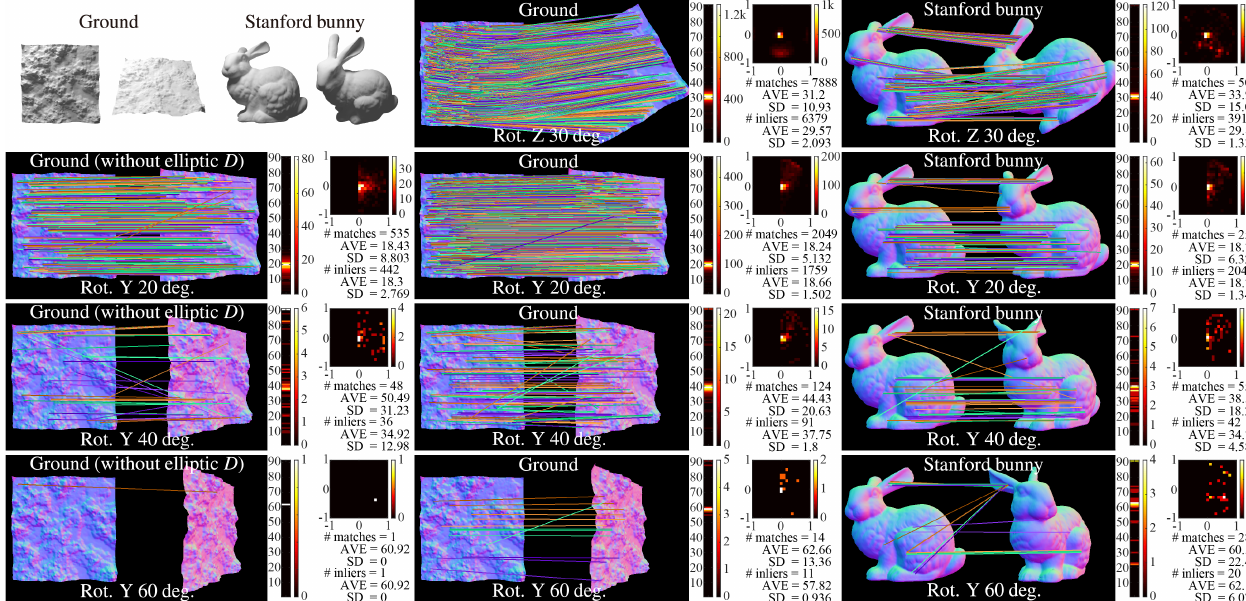
Figure 4. Estimated motion between images of a rigid body model, “Ground” or “Stanford bunny”, and the rotated one, using BIFNOM. For each case, a histogram and statistics for estimated rotation angles and a heat map for estimated rotation axes are described. In the heat map, XY components of a unit direction vector of the rotation axis are shown for the rotation around the Z axis, and XZ components are shown for the rotation around the Y axis, and so the ground truth will appear as a center spot. The first column shows the importance of the elliptic region D